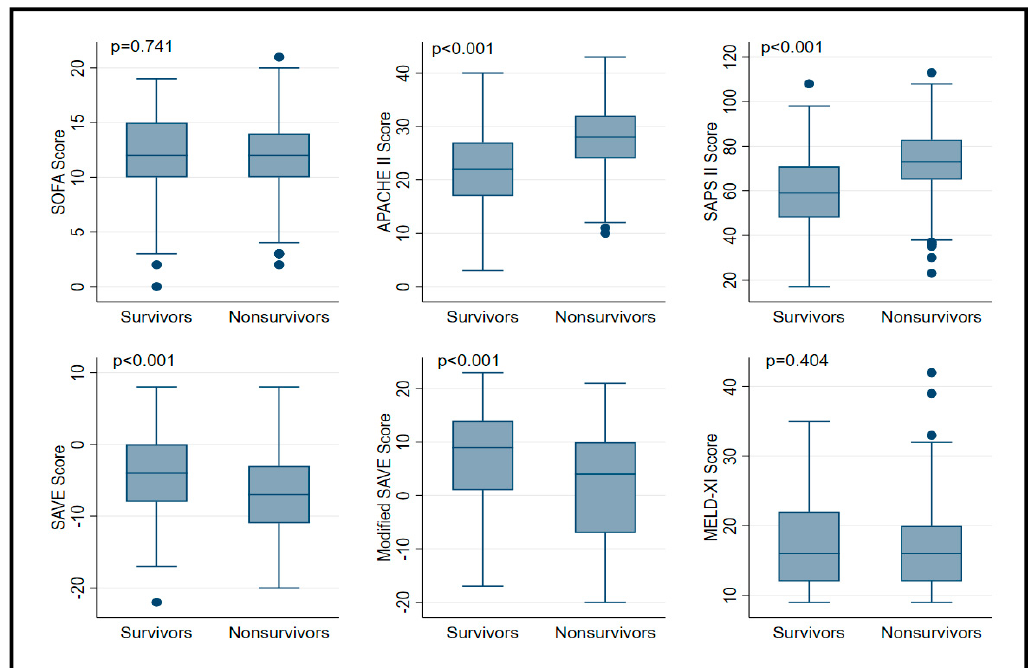
Figure 1. Boxplot of prognostic score values in in patients supported with veno-arterial extracorporeal membrane oxygen- ation according to survivors and non-survivors. Data are expressed as median, minimum, maximum, 25. percentile, and 75. percentile.